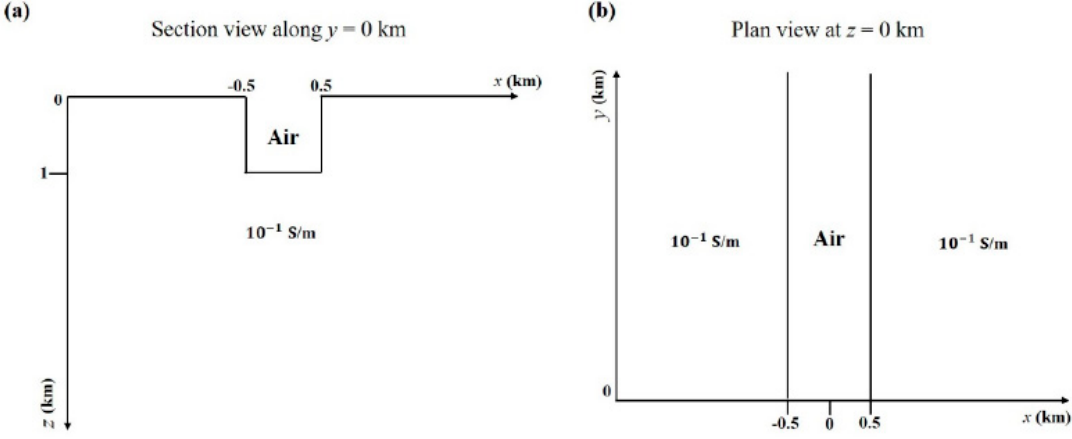
Figure 6. Sketch of the canyon model. ( a ) x - z section view along y = 0 km, ( b ) x - y plan view at z = 0 km.